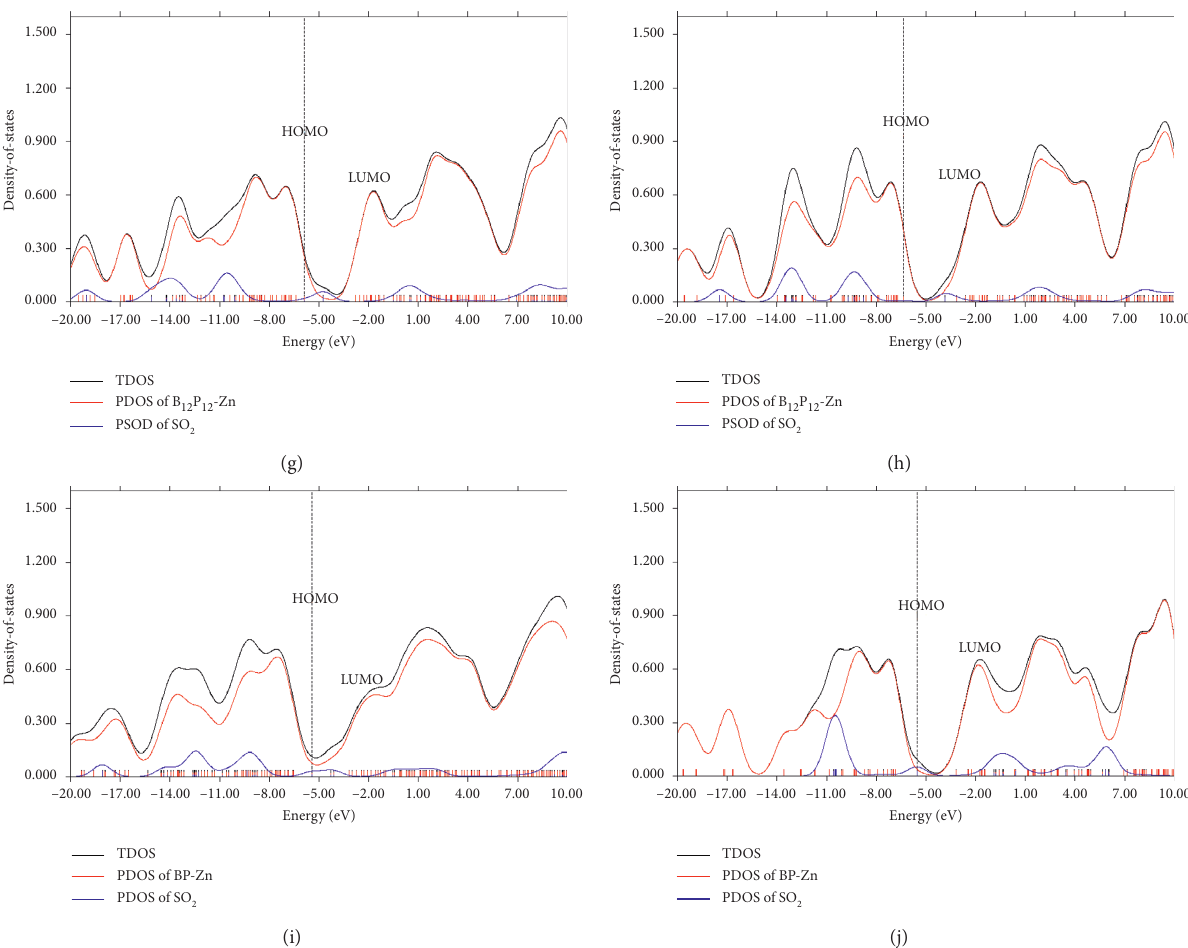
Figure 6: Different systems with TDOS and PDOS graph. The isosurfaces is 0.02e/˚A 3 . (a) B12P12 nanocage. (b) B (e) M3. (f) M4. (g) N1. (h) N2. (i) N3. (j)